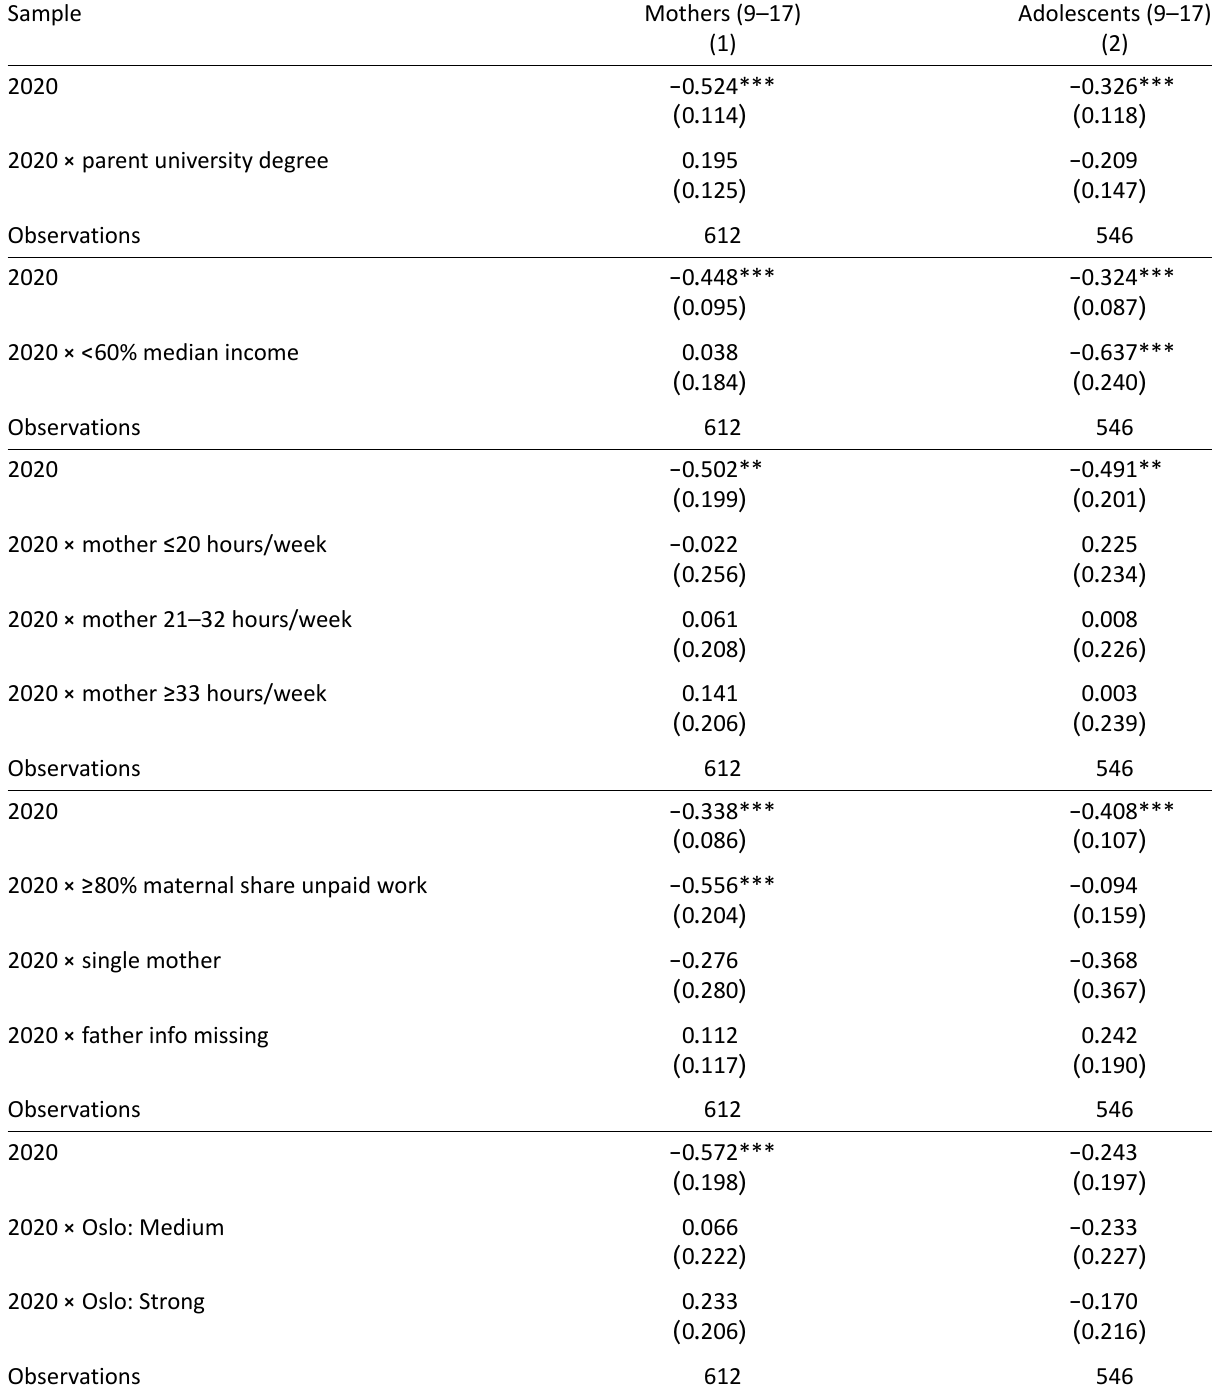
Table 3. Changes in family climate by education, poverty, maternal labor market attachment, division of unpaid care work, and social